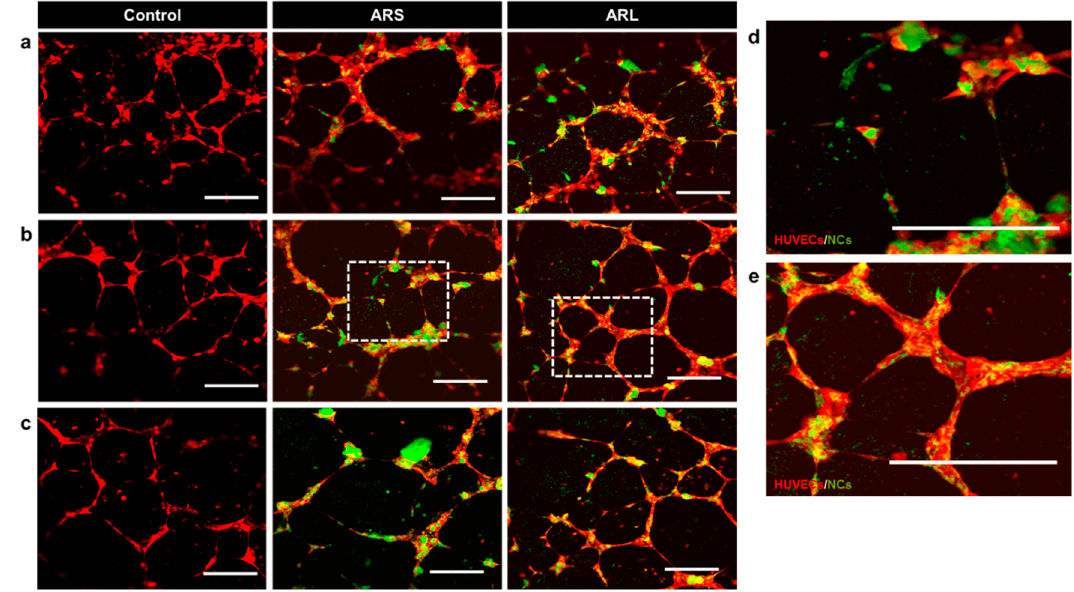
Figure 4. Confocal images of human umbilical vein cells (HUVECs) cultured on matrigel substrates when NCs were treated for ( a ) 6 h; ( b ) 12 h; and ( c ) 24 h (red: RFP-HUVECs/green: Alexa 647-tagged NCs). Zoomed images of HUVECs cultured with ( d ) ARS and ( e ) ARL after 12 h. Scale bar = 200 μ m.